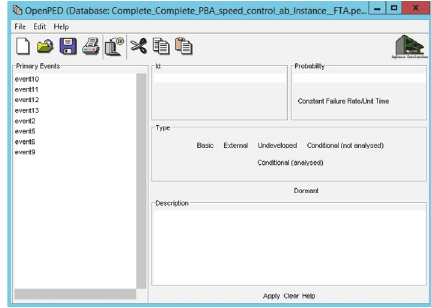
Figure 4: PED view in